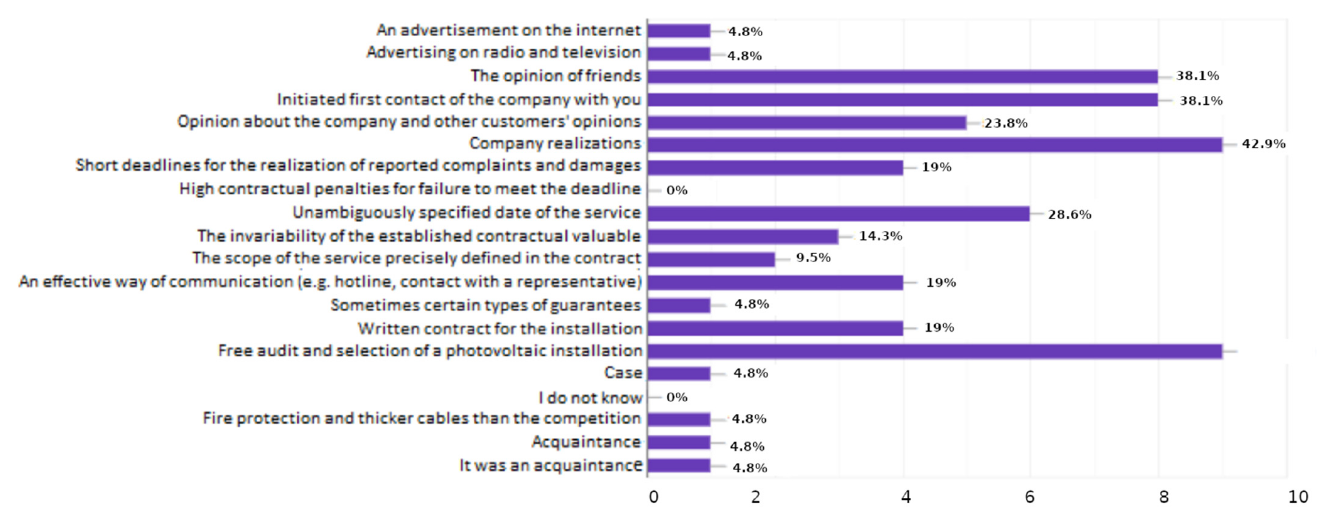
Figure 18. Elements influencing the choice of service provider.